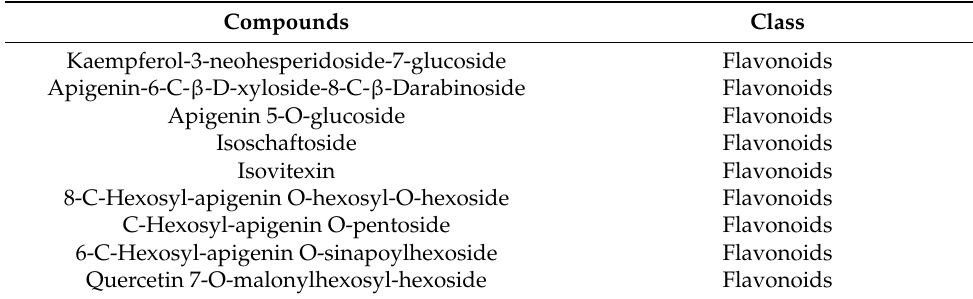
Figure 7. Heatmaps of hierarchical cluster analysis (HCA): ( a ) GP vs. RS vs. ZJ; ( b ) The 22 different metabolites commonly found in RS, GP and ZJ samples. The abscissa is used to display the names of samples, and the ordinate on the right is used to display the classes or names of metabolites. The deeper the red color, the higher the content of the metabolites; the deeper the green color, the lower the content of the metabolites. Table 3. A total of 22 different metabolites shared metabolites that differed significantly in terms of content among the RS vs. GP vs. ZJ